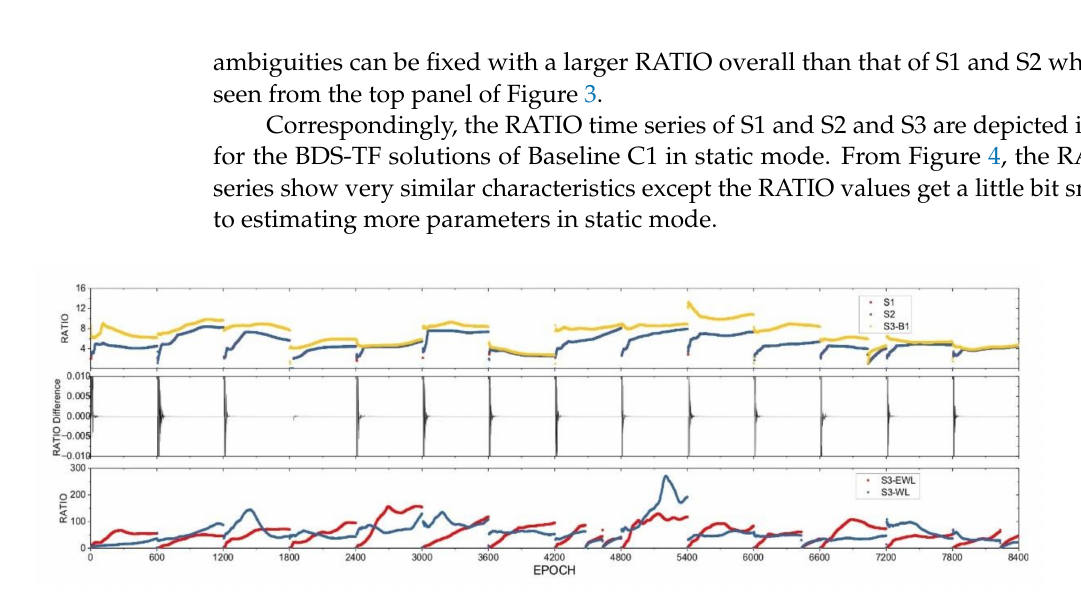
Figure 4. Time series of ambiguity-fixing indicator RATIO of the fixing scheme S1 and S2 ( top ), and their differences ( middle ), and that of EWL and WL fixing of S3 ( bottom ), the RATIO of B1 fixing in S3 is also shown at the top panel for the BDS-TF solutions of Baseline C1 in kinematic